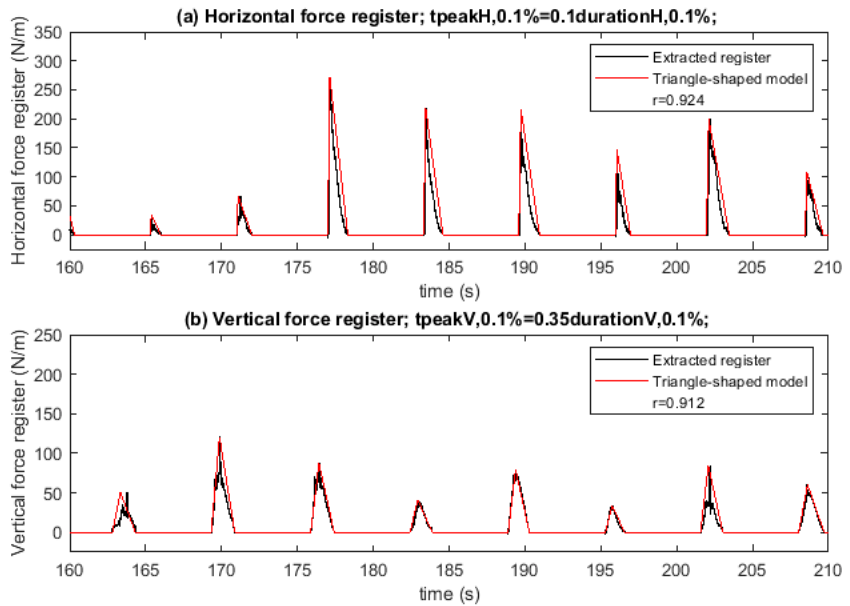
Figure 10. Comparison of Extracted register (the actual maximum force events) and the triangle-shaped model using the measured F H,0.1% , F V,0.1% , and duration 0.1% for: ( a ) horizontal forces, and ( b ) vertical forces.